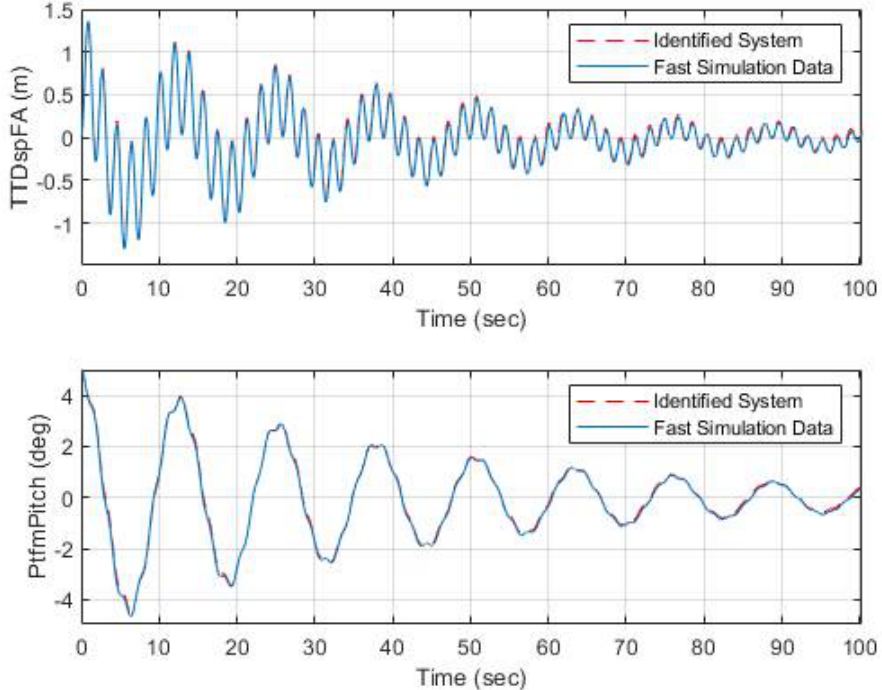
Figure 4. Validation results of the identified model (red) and FAST-SC simulation (blue) with a TMD. Initial platform pitch angle was 5°.